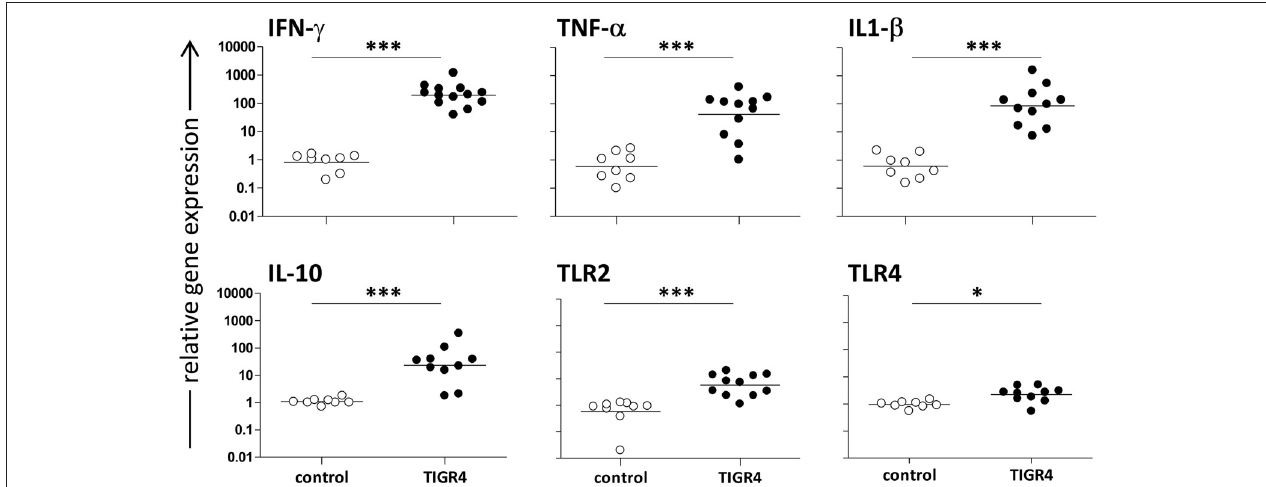
FIGURE 2 | Cytokine and TLR gene expression in the mouse brain 48h post infection. The relative IFN- γ , TNF- α , IL-1 β , IL-10, TLR2, and TLR4 gene expression was determined by RT-PCR in brains of C57BL/6J mice infected by the intracranial route with 3 × 10 4 CFU of S. pneumoniae TIGR4 (filled circles). As control, a group of mice was injected with bacteria growth medium (open circles). All animals were sacrificed 48h post infection. Symbols represent individual mice and bars represent the geometric mean of each group. Data are from two independent experiments with 4–6 mice/group. Statistical analysis was performed on log-transformed data between infected and control group using the two tailed Mann-Whitney test. Asterisks indicate statistical significance ( * P ≤ 0.05 ; *** P ≤ 0.001